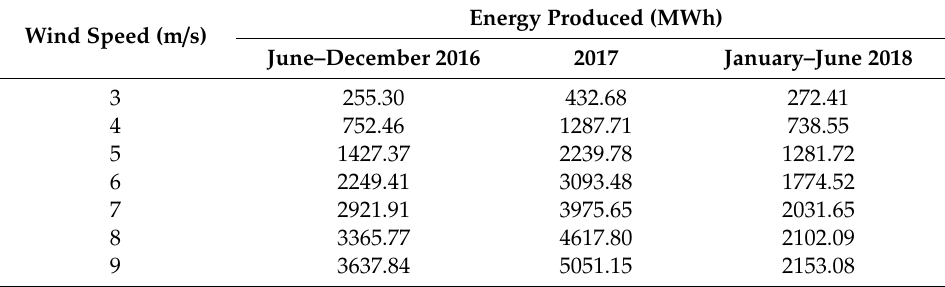
Table 9. Wind farm energy production (five wind turbines).